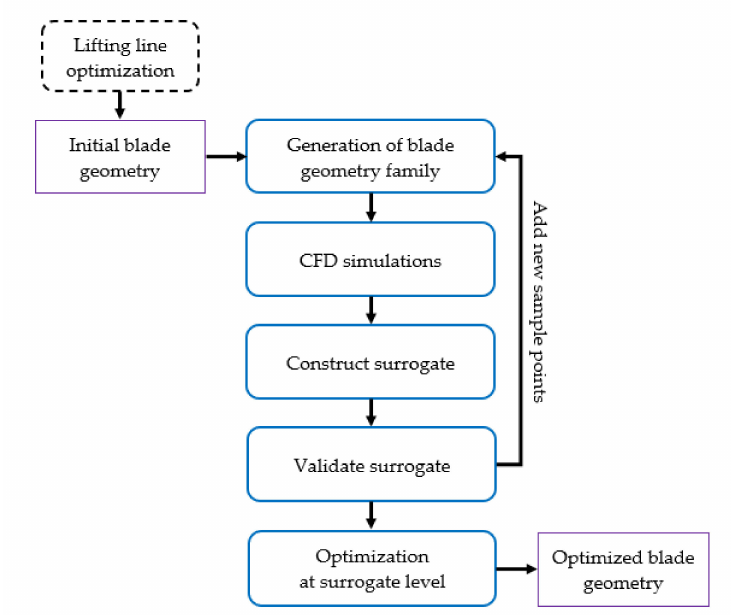
Figure 4. Optimization